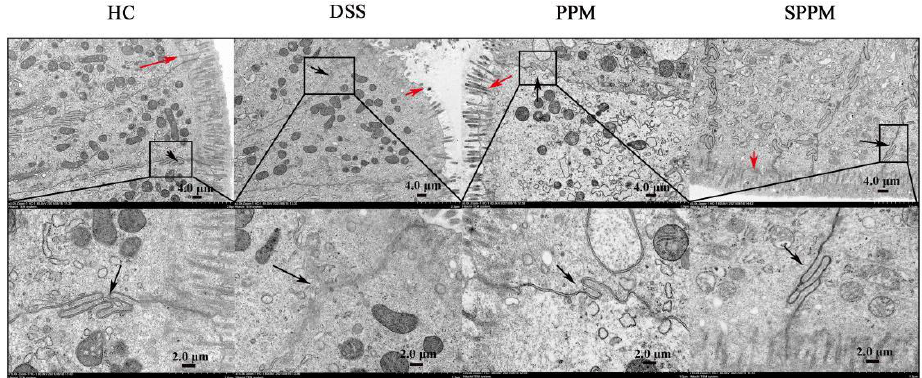
Figure 4. Transmission electron microscopy of tight junctions in mouse colonic tissue. The red arrow points to the microvilli on the epithelial surface of the colon mucosa and the black arrow points to the tight junctions of cells.